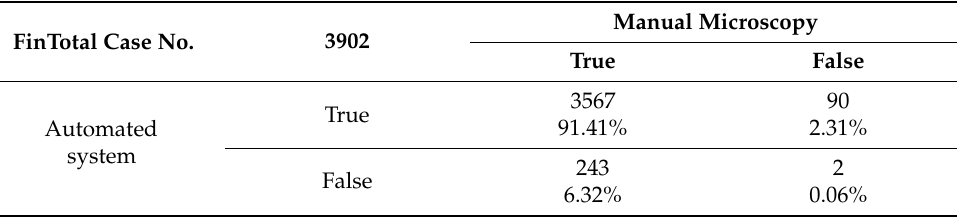
Figure 6. The confusion matrix of automation system with 200 images capture setting after removal of inadequate cases. Table 5. The precision and error rate of the automation system and manual microscopy. The “True” represents the cases diagnosed correctly; The “False” represents the cases of wrong diagnosis. FinTotal Case No.